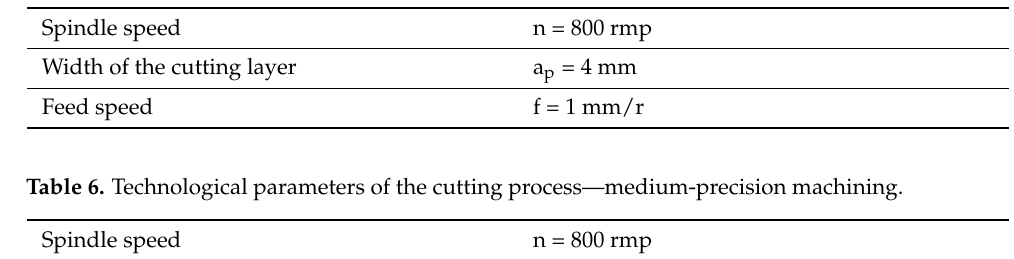
Table 4. Parameters of ISC techniques.